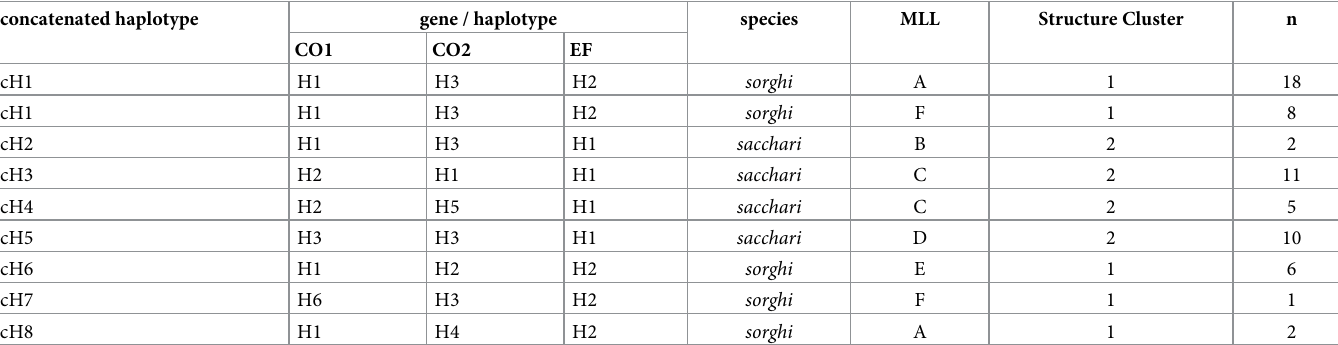
Table 4. Haplotypes defined by the concatenation of four genes and correspondence with the Multilocus Lineages (MLLs) defined using